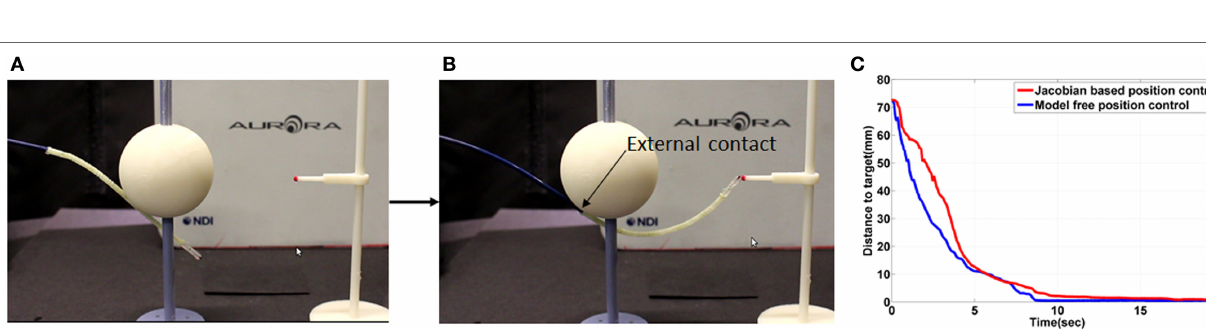
FigUre 14 | (a) Initial shape of the catheter in the external contact experiment (B) shape of the catheter after contact on the target location using the free model position control (c) the absolute distance error during the external contact experiment.